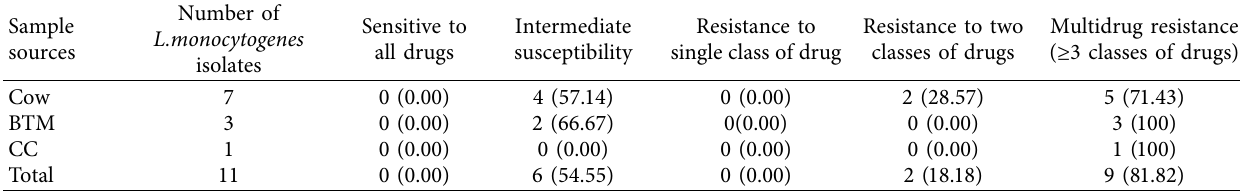
Table 8: Comparison of antimicrobial resistance profile of L. monocytogenes isolated from different